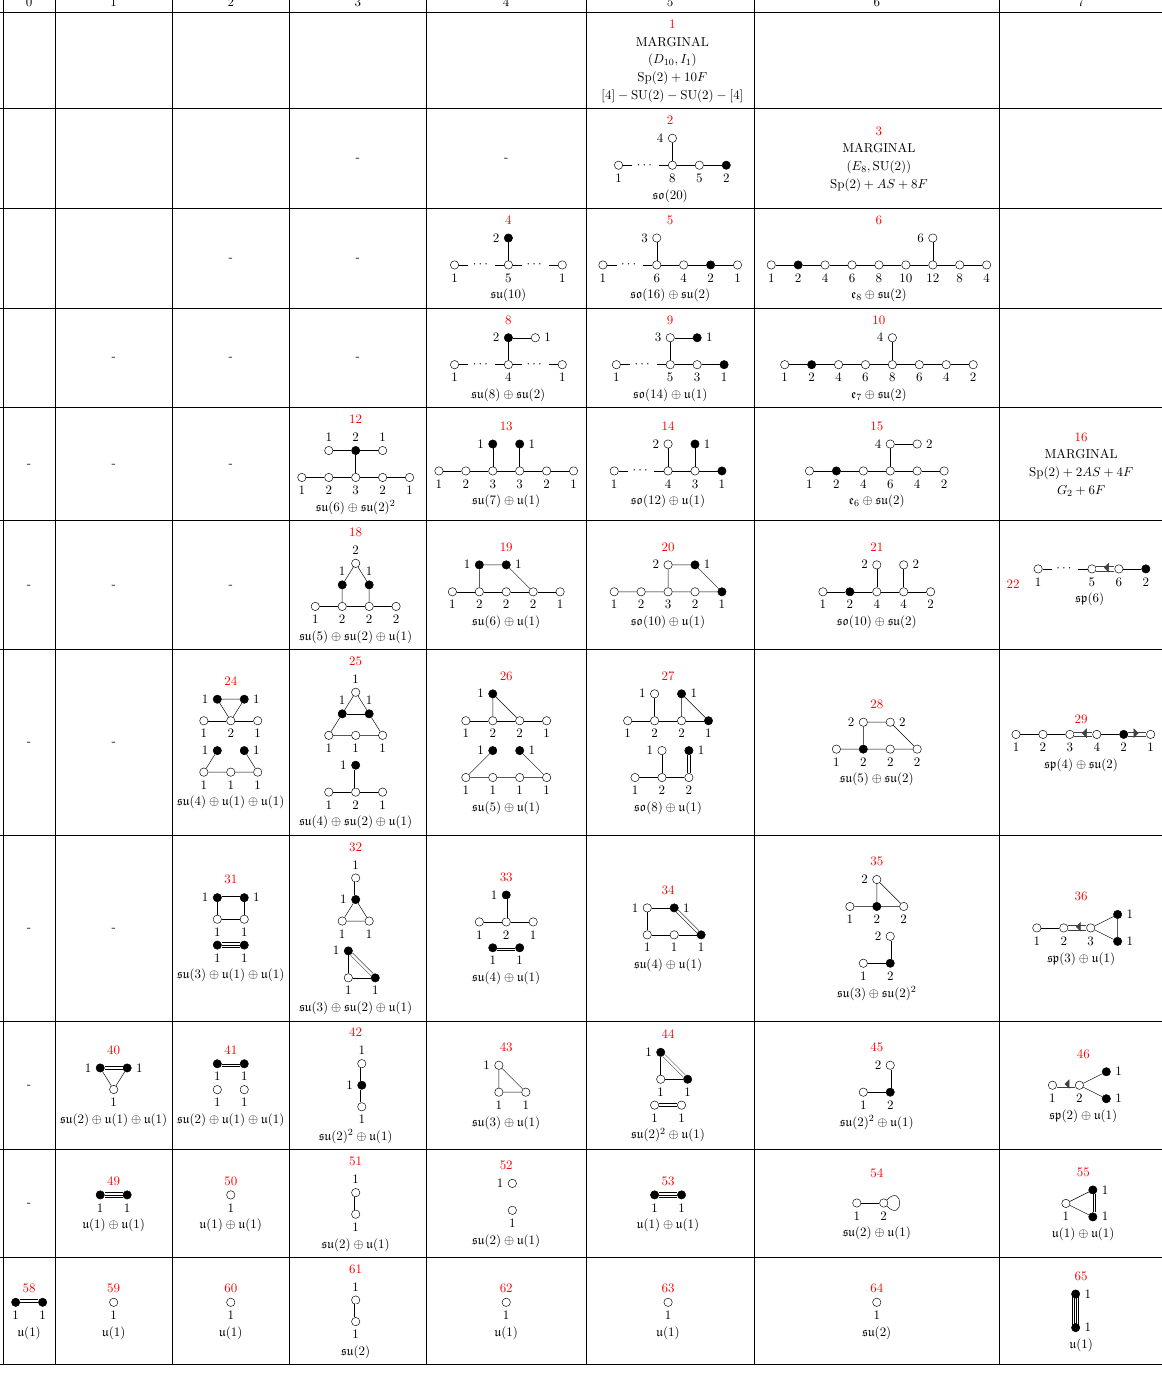
Table 8 . Decoupling tree for rank 2 5d SCFTs with an SU(3) k + N F F description: the marginal theories are ( D ) conformal matter, rank 2 E-strings, and the model 3. We show the IR gauge 5 , D 5 theory description of these, and in each model list also the non-abelian flavor symmetry algebra. The rows are labeled by N , the columns are labeled by N F + k . The red numerals correspond F 2 to the enumeration in appendix A.2 of [16]. Decoupling a fundamental hyper while increasing corresponds to moving one box downwards (resp. one box k (respectively decreasing k ) by 1 2 diagonally to the bottom left). The dashes correspond to quivers which can be obtained from other boxes by the symmetry k → − k